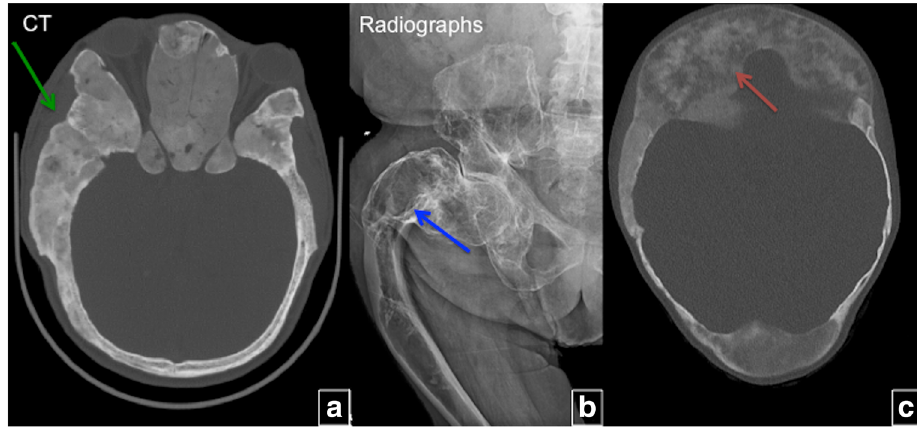
trabeculae ( b ) within a fibrous stroma ( ft ), demonstrating the typical “ alphabet soup ” pattern. Goldner ’ s trichrome stained sections in low ( c ) and high power ( d ) reveal osteomalacic changes including excess osteoid ( asterisks ) and severe undermineralisation of the dysplastic bone (reprinted from Boyce [34])